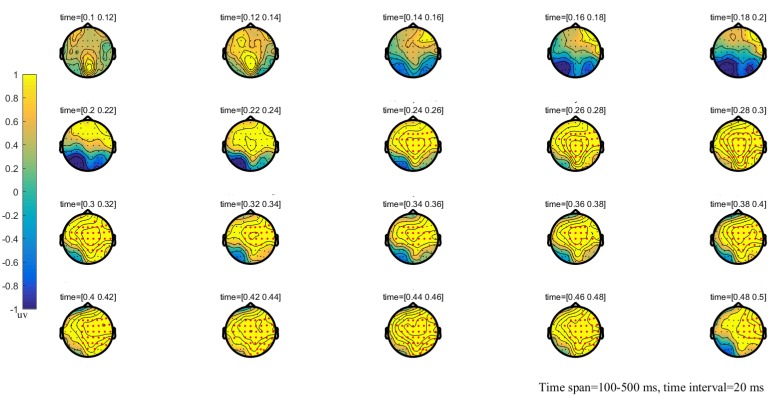
The global topographic map of the difference between MT and HT, time from 100 to 500 ms after stimulation onset. The results showed that the difference of waveform between the two stimuli is mainly reflected in the right posterior brain area of 260–330 ms and the frontal-parietal and posterior area of 330–500 ms after stimulation onset. Red points indicate that these electrodes are members of significant clusters.